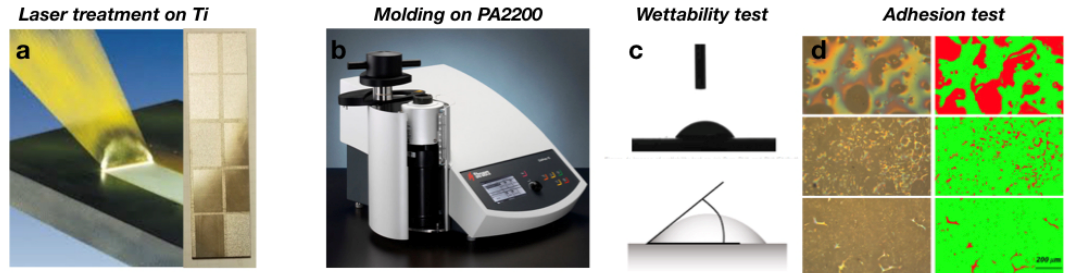
Figure 1. Process set up for microstructure modification on ( a ) Titanium by laser texturing, ( b ) stamping process on PA2200, ( c ) wettability tests on Titanium and PA2200, ( d ) adhesion test on PA2200.